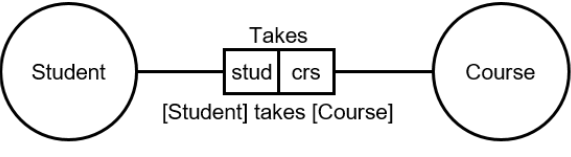
Figure 1. Graphical representation of label types and fact